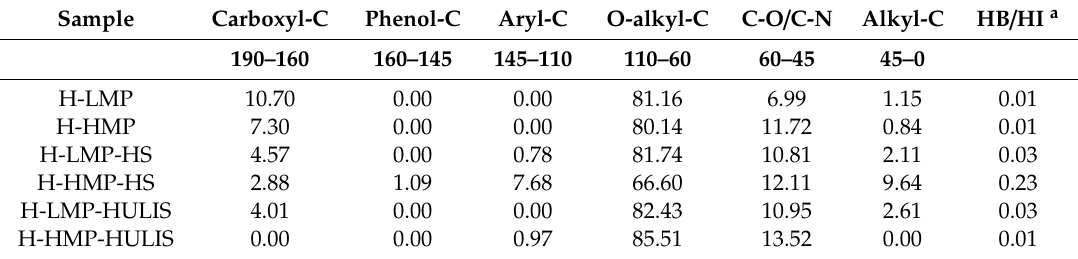
Table 1. Relative carbon distribution (%) over chemical shift regions (ppm) in 13 C CPMAS NMR spectra of hydrogels containing only low methyl-esterified pectin (H-LMP), high methyl-esterified pectin (H-HMP), or in combination with either humic substances isolated from cow manure compost (H-LMP-HS and H-HMP-HS) or humic-like substances from depolymerized lignocellulose biorefinery residues (H-LMP-HULIS and H-HMP-HULIS).